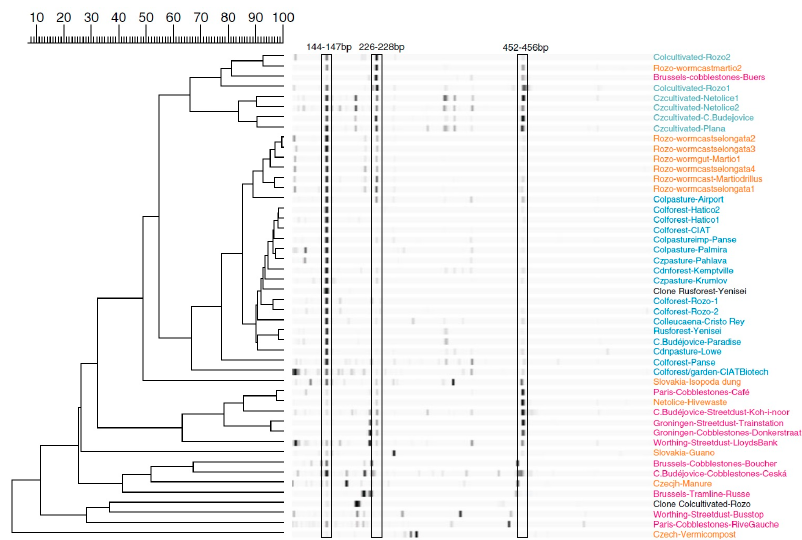
Figure 4. Forward Terminal Restriction Fragment Length Polymorphism (T-RFLP) community fingerprints of the Actinobacteria from Uncultivated soil (blue) Cultivated soils (green), animal associated sediments (orange) and street dust (red). Reproduced from Hill et al., Microb. Ecol. , published by Springer International Publishing AG., 2011 [46]